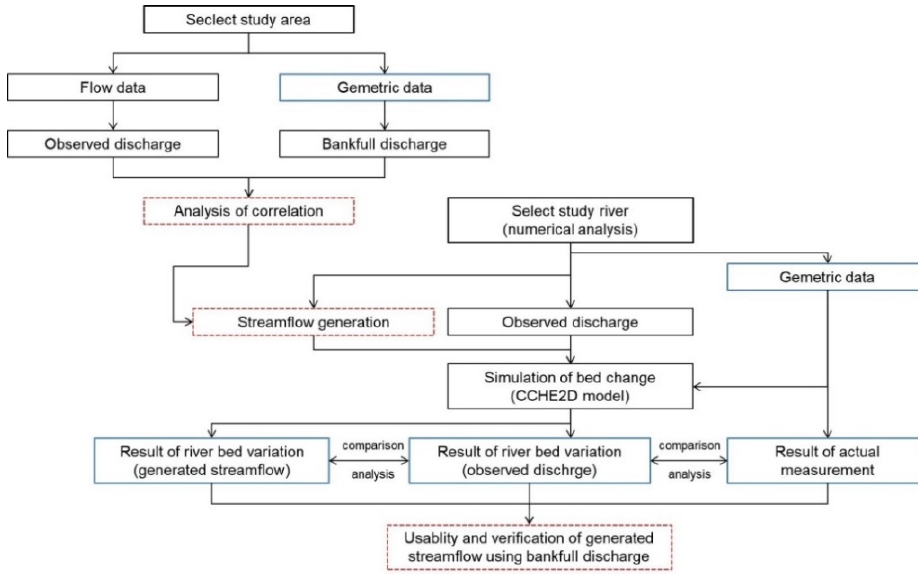
Figure 2. Flow chart of stream flow generation for simulating yearly bed change.